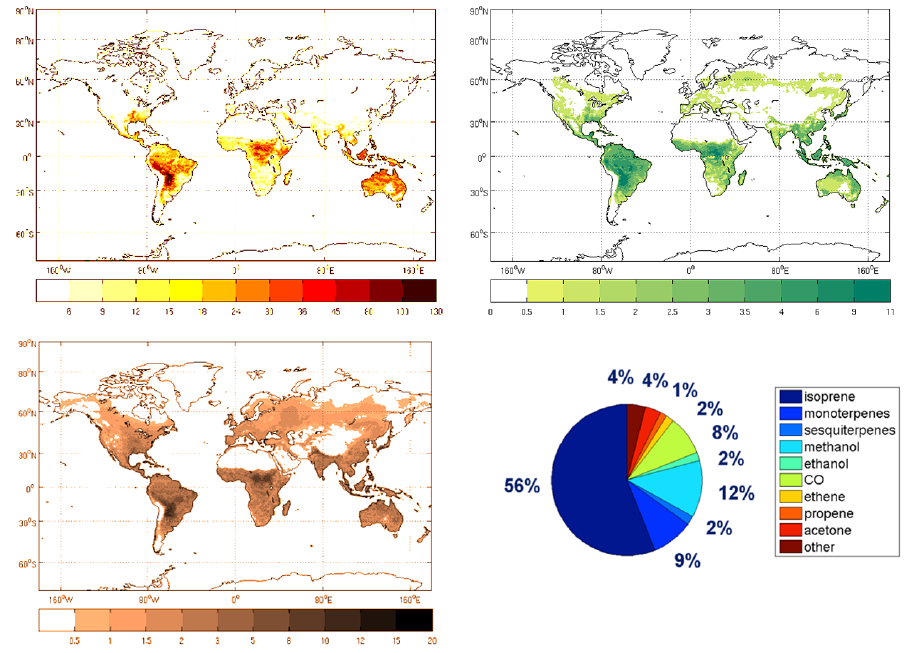
Figure 20. Mean annual emissions (in mgm − 2 day − 1 ) of isoprene (top left), monoterpenes (top right), methanol (bottom left), and contri- bution of each BVOCs to the annual global total average (bottom right) (Sindelarova et al.,